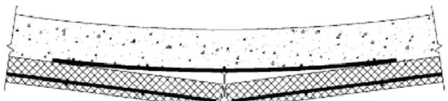
Figure 13: Interface detachment and stress in crossbar